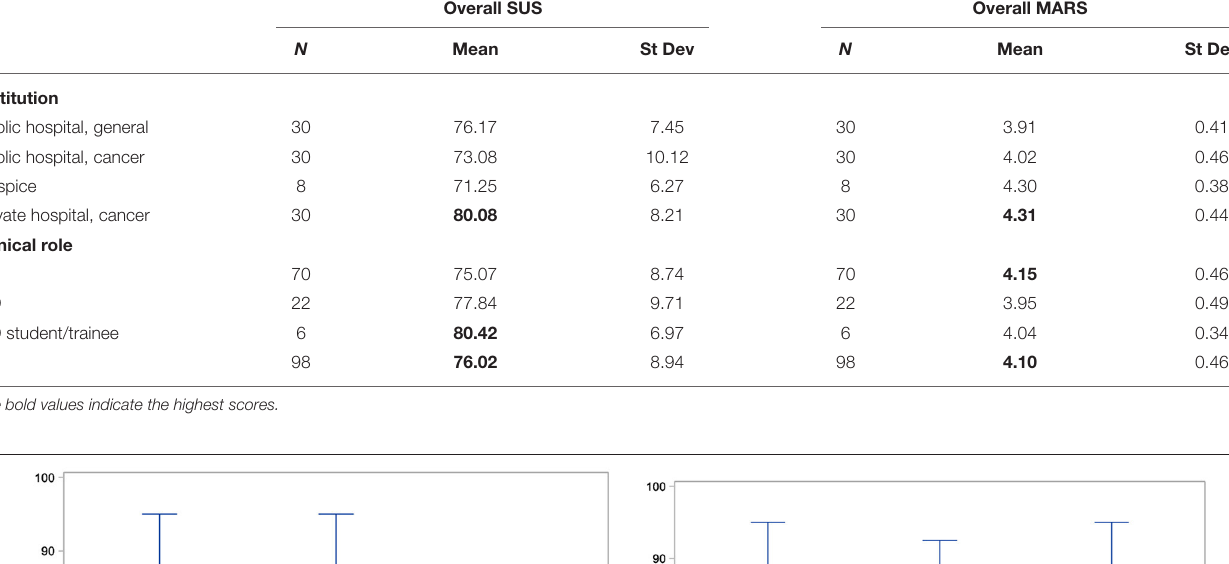
TABLE 8 | Overall SUS and MARS scores, by institution and role. Overall SUS Overall MARS